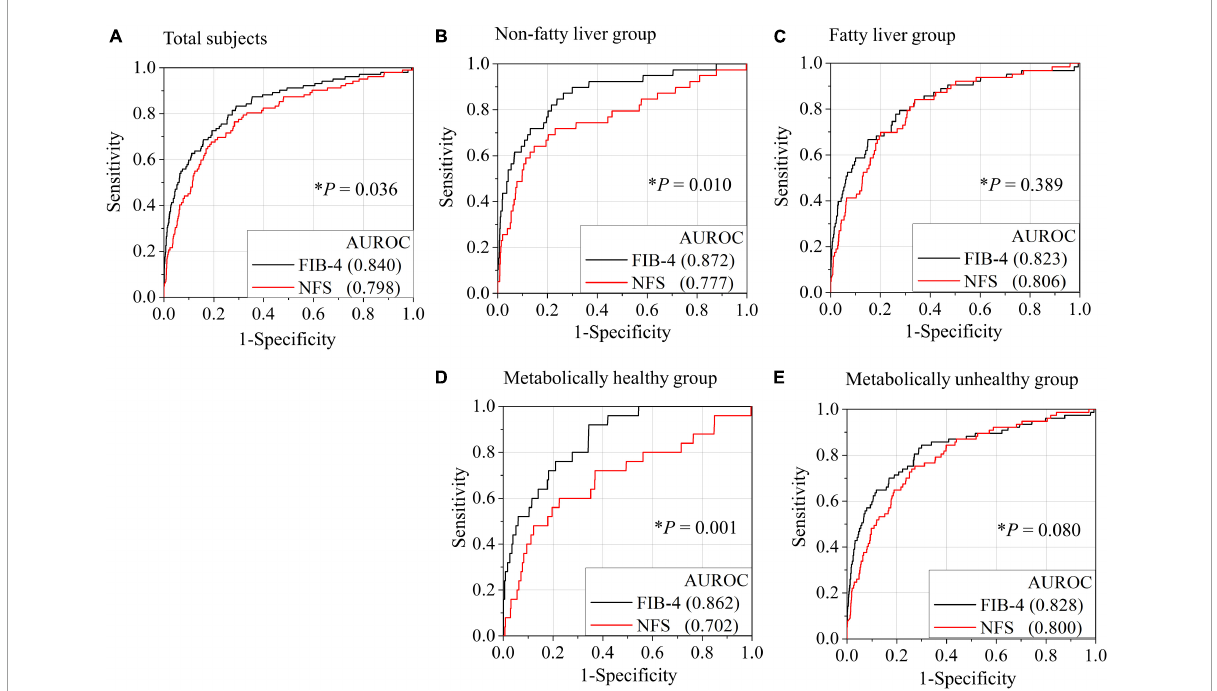
FIGURE2 Comparison of AUROCs for advanced hepatic fibrosis ( ≥ 3.6 kPa) between FIB-4 and NFS based on the presence of fatty liver or metabolic status. Receiver operating characteristic (ROC) curves for the diagnosis of advanced fibrosis by FIB-4 or NFS in all subjects (A) , non-fatty liver group (B) , fatty liver group (C) , metabolically healthy group (D) , and metabolically unhealthy group (E) . A metabolically healthy state was defined as having less than two metabolic risks and not having diabetes. ∗ P -value when the ROC curve by FIB-4 was compared with the ROC curve